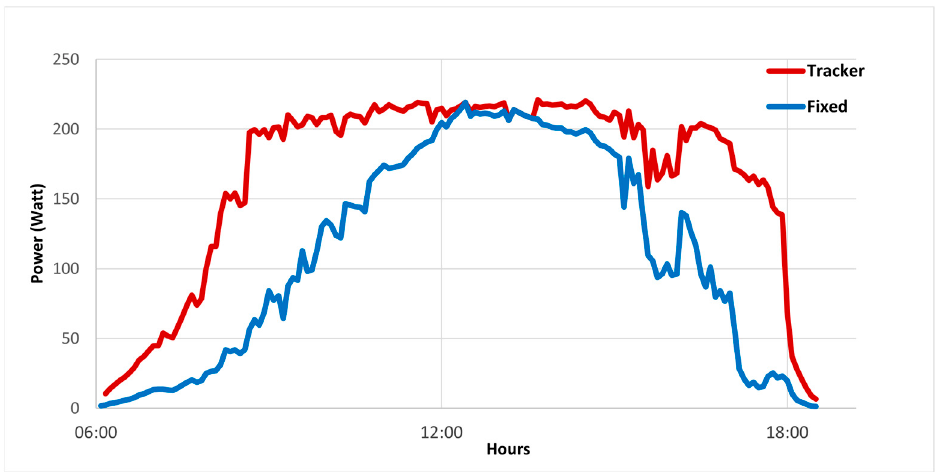
Figure 18. Daily generated power changes of the solar tracker and the fixed PV system.